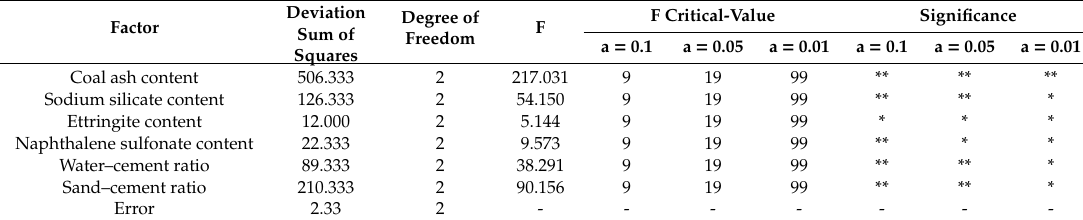
Table 7. Analysis of variance of bond stress in the orthogonal test.